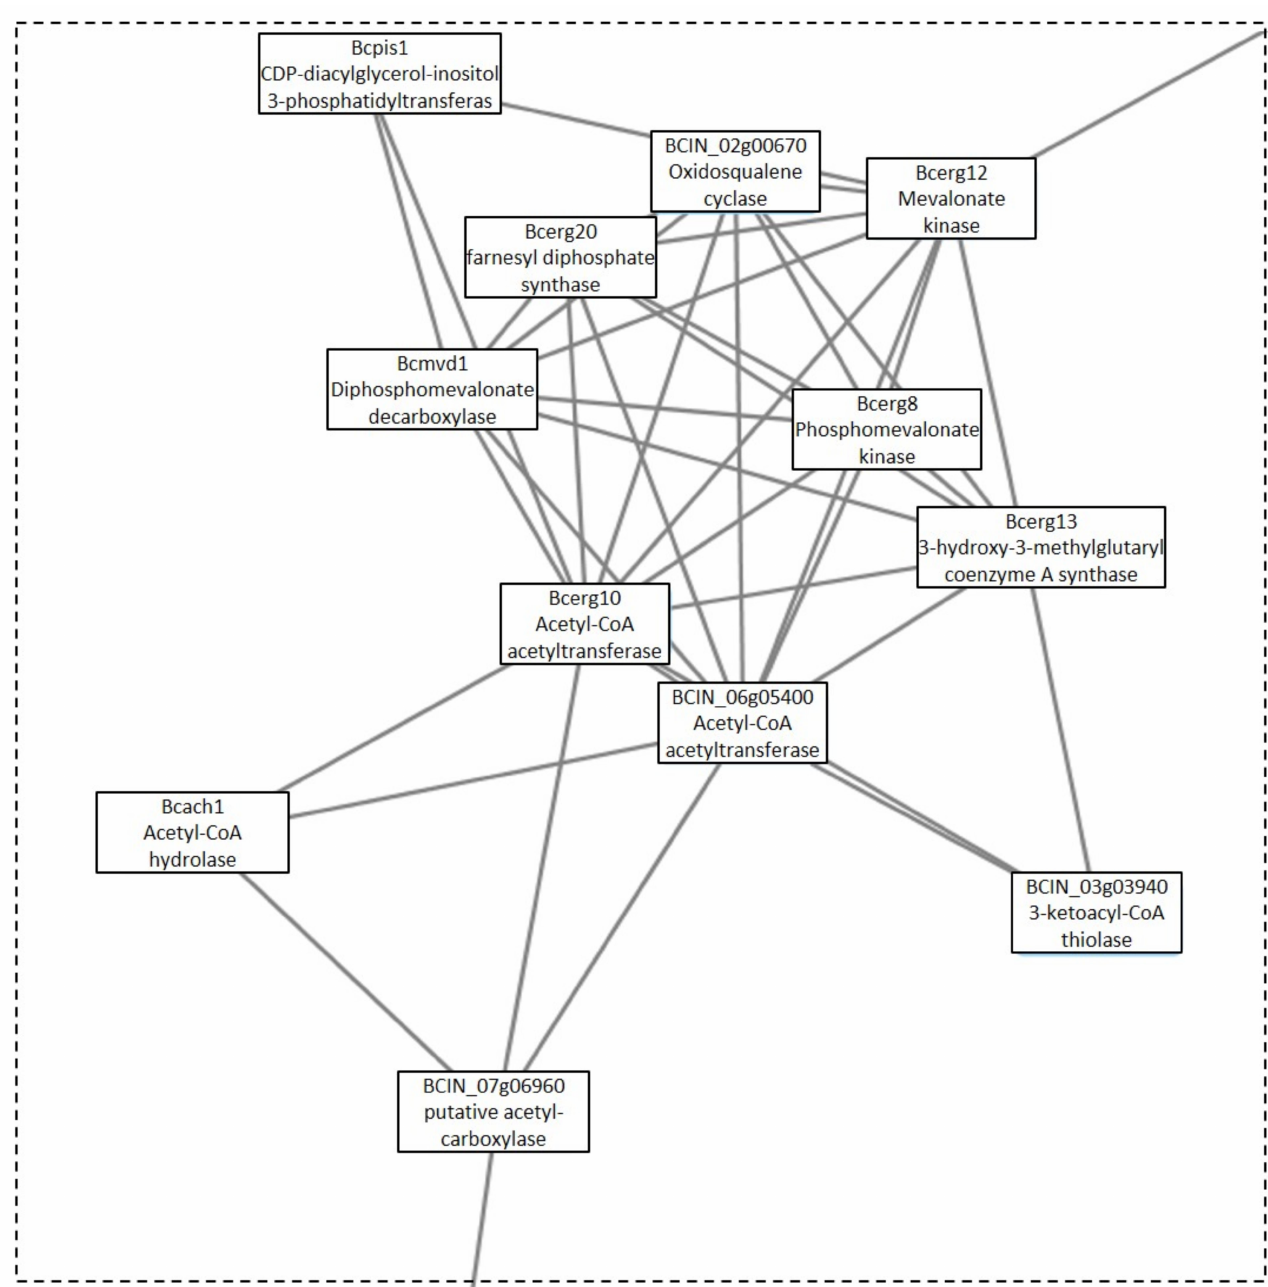
Figure 9. Section B from Cluster 10 (Figure